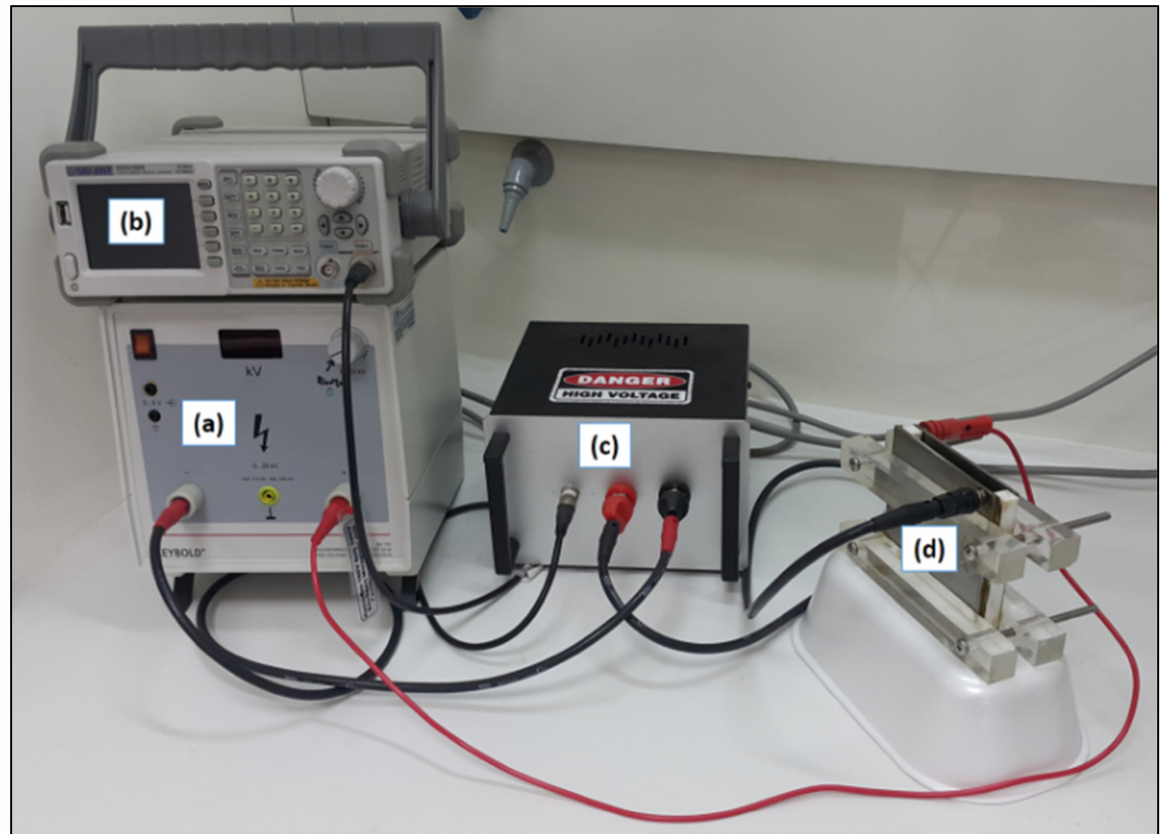
Figure 2. PEF System: ( a ) high-voltage power generator; ( b ) function/arbitrary waveform generator; ( c ) electronic switch circuit (IGBTs); ( d ) treatment